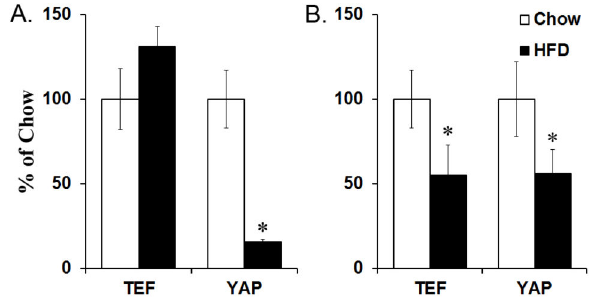
Figure 1. mRNA levels of TEF and YAP. (A) The mRNA was measured via qRT-PCR in the PVN of P15 offspring prenatally exposed to high-fat diet (HFD) or chow, and a statistically significant decrease was found in YAP expression from offspring that were prenatally exposed to high-fat diet (HFD) compared to chow. (B) The mRNA was measured in whole hypothalamic tissue of E19 embryos prenatally exposed to HFD or chow, and a statistically significant decrease was observed for both TEF and YAP expression from HFD embryos compared to chow. The mRNA levels were normalized to cyclophilin and calculated using the CT comparative method. Results are expressed as means ± SEM (n = 6–9). * p < 0.05, transcription enhancing